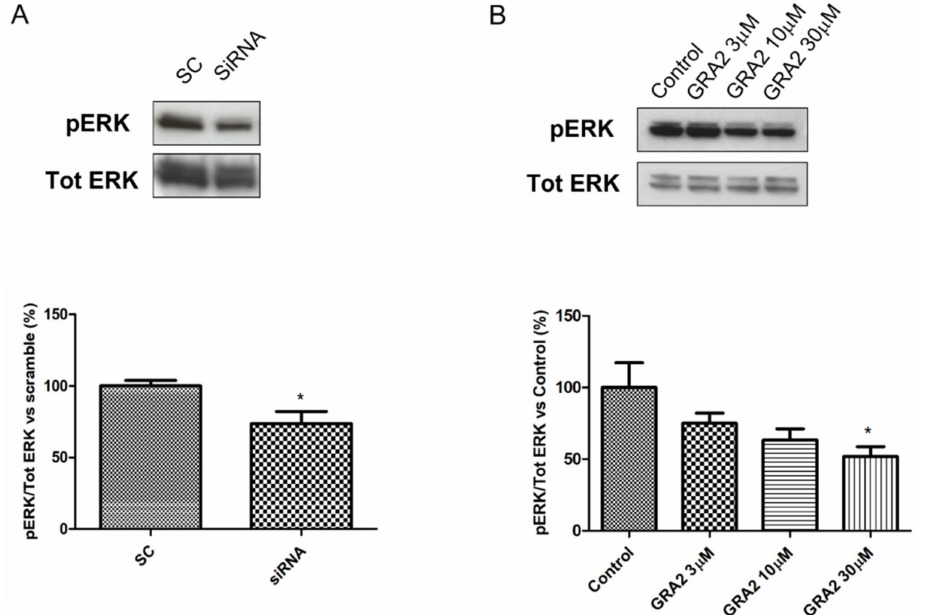
Figure 7. Effect of GPR21 gene silencing and GRA2 treatment on ERK activation. Western blot analysis of the phosphorylation levels of the MAPK ERK1/2 in HepG2 cells transfected for 72 h with non-silencing siRNA (scramble control, SC) or with specific Scheme 21. (siRNA, panel ( A )) as well as in HepG2 cells exposed to increasing concentrations of the inverse agonist GRA2 (3–30 µ M, 24 h, panel ( B )). Equal loading was evaluated by a re-probing membrane with total ERK1/2. Densitometric analysis of the bands is expressed as relative optical density (O.D.) and normalised using the related control band. Data are expressed as mean ± SEM; n = 3. * p < 0.05 vs. scramble control (SC) or